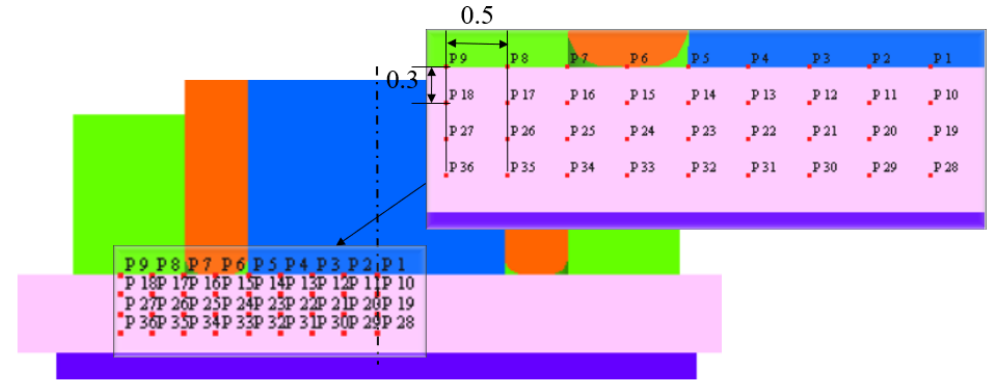
Figure 6. Initial positions of characteristic points using point tracking for material flow analysis.